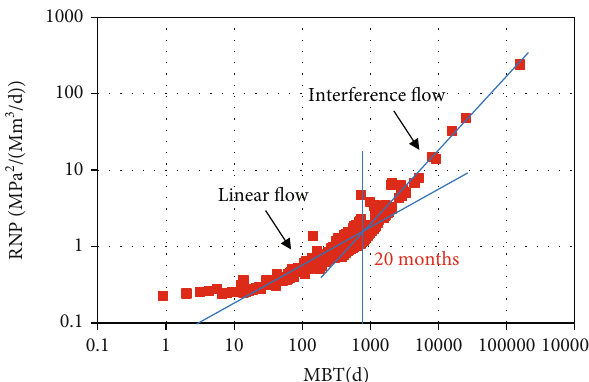
Figure 6: Typical fl ow stage of gas (normalized pressure).